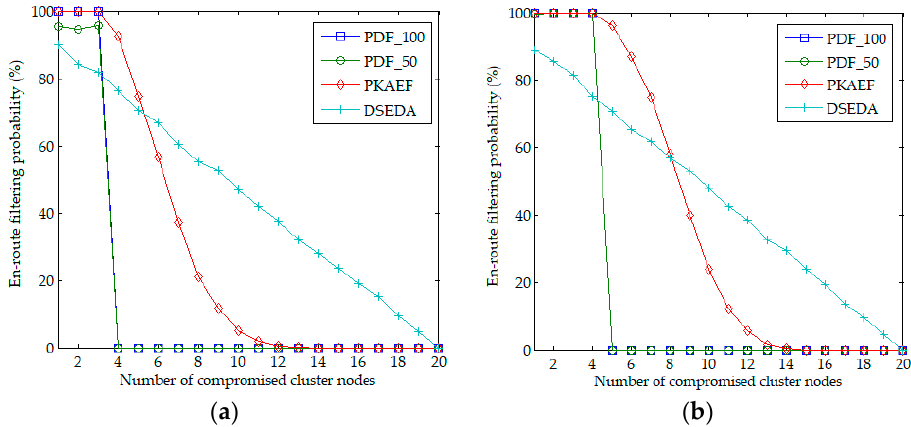
Figure 3. En-route filtering probability as a function of the number of compromised cluster nodes. ( a ) in Scenario 1; ( b ) in Scenario 2.